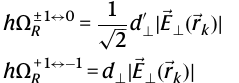
external magnetic fi eld splits the NV spin m s =±1 sublevels, while an electric fi eld E (cid:3) splits the excited state levels ∣ E x and ∣ E y by Δ xy via the DC Stark effect (left). The black (yellow) line indicatesthe Rabi transition between ∣ ±1 i $ ∣ 0 i ( ∣ +1 i $ ∣ (cid:4) 1 i ) t b driven by a resonant transverse electric fi eld. c The SiV center in diamond in the k ( V k ) for spin control. [111] direction with transition dipoles ~ μ 1 = ½ 1 (cid:2) 10 (cid:3) and ~ μ 2 = ½ (cid:2) 1 (cid:2) 12 (cid:3) . d Level structure of SiV. The optical `C' transition is resonantly addressed, and enhanced by the FPSA E E slow-light mode. The ∣ e g + " and ∣ e g (cid:4) # levels are split in an external magnetic fi eld, and used as a qubit with strain-driven quantum